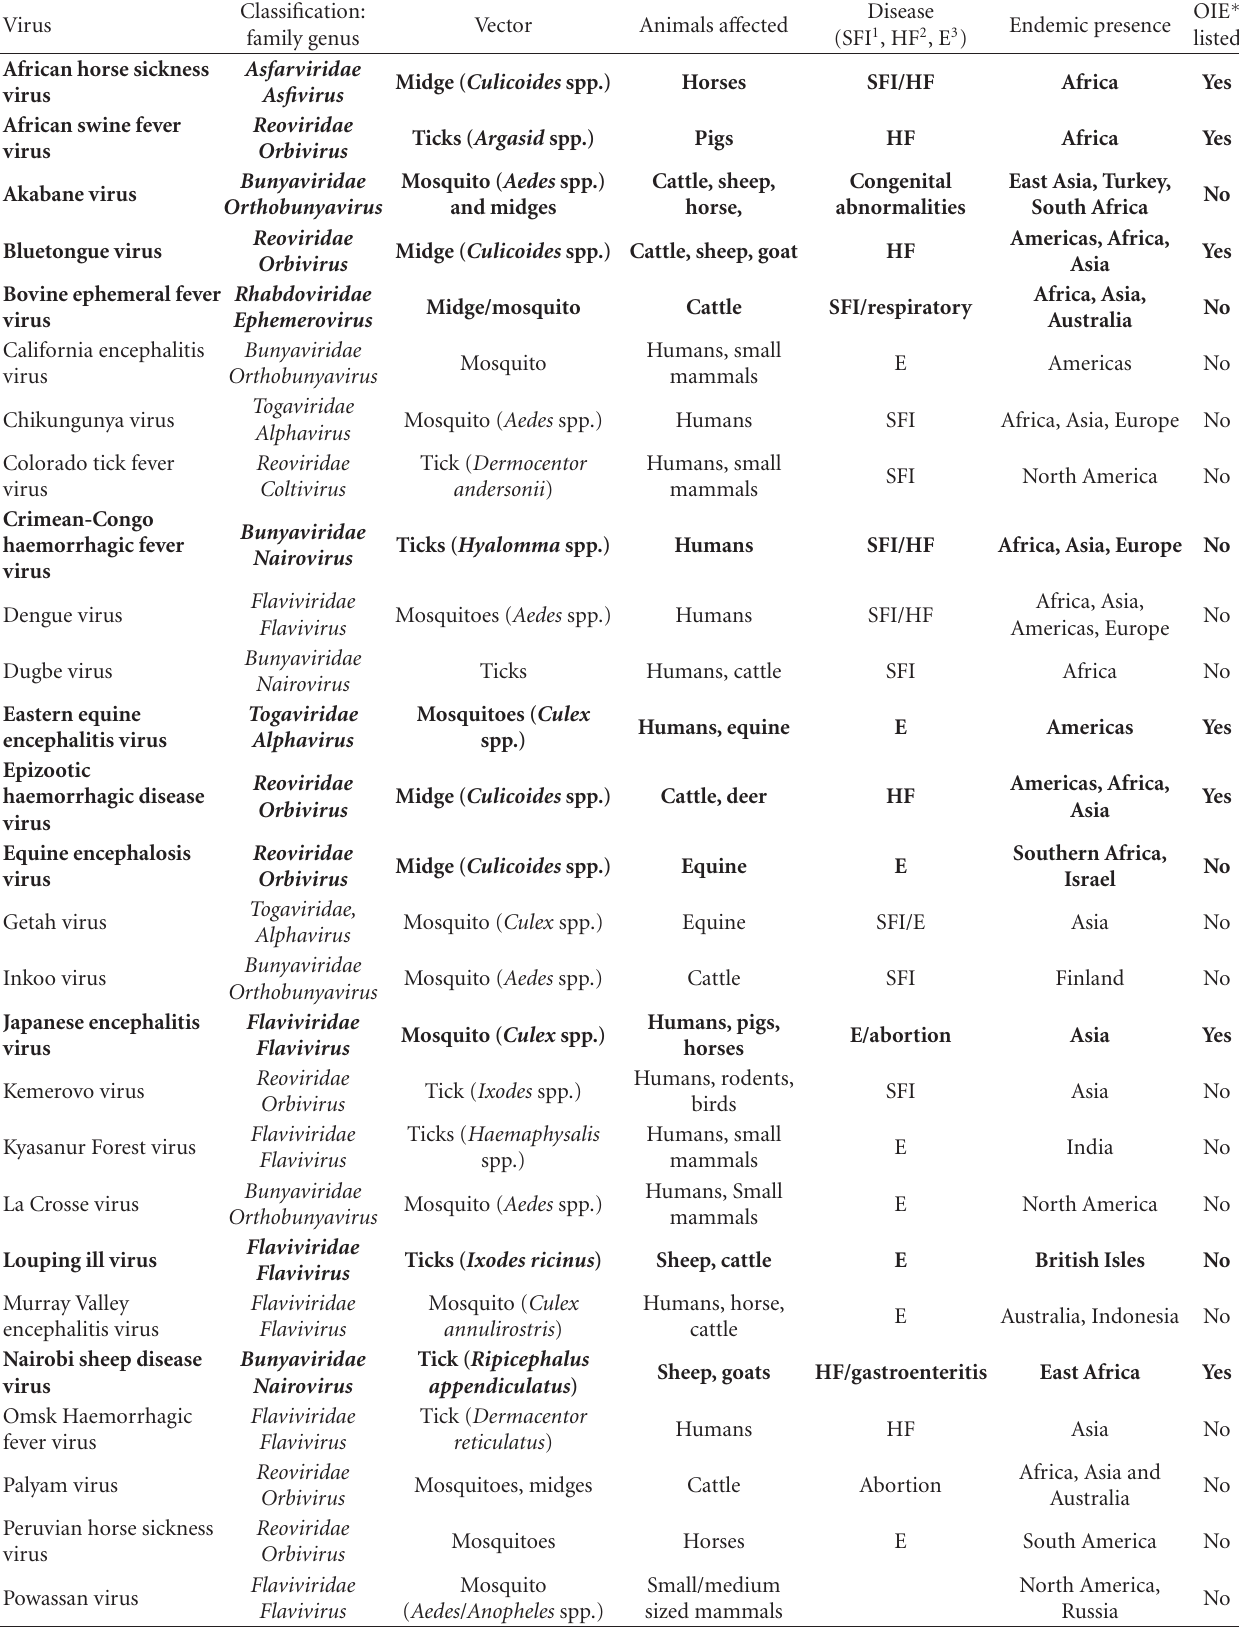
Table 2: Pathogenic arboviruses (viruses in bold are dealt with in greater detail later in the